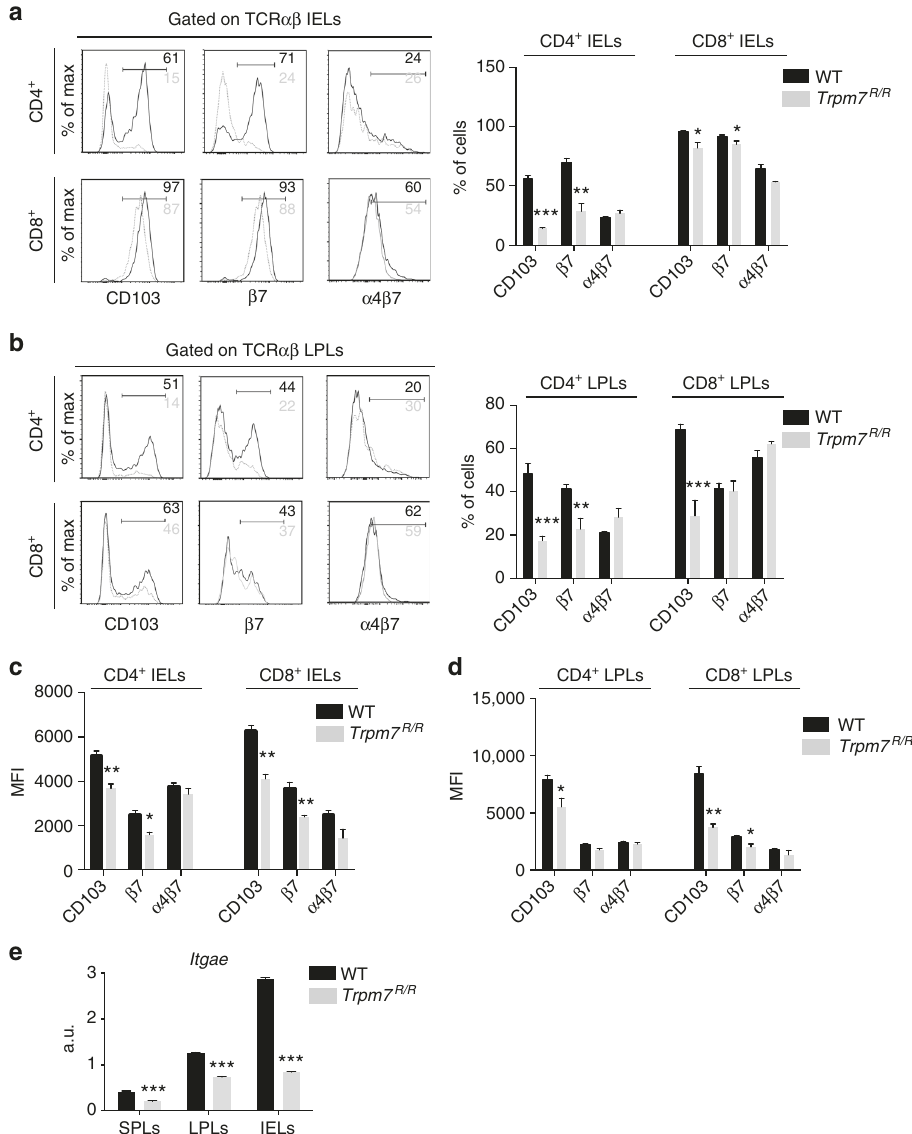
Fig. 3 Trpm7 R/R mutation affects α E β 7 expression in T cells. a Representative histogram overlay of cell surface CD103, β 7 and α 4 β 7 expression of intra- epithelial lymphocytes (IEL, left) and relative statistical analysis (right). Percentages are shown in each gate, bar charts show mean percentages ± s.e.m. ( n = 4). b Representative histogram overlay of cell surface CD103, β α β 7 and 4 7 expression of lamina propria lymphocytes (LPL, left) and relative statistical analysis (right). Percentages are shown in each gate, bar charts show mean percentages ± s.e.m. ( n = 4). c Surface CD103, β 7 , and α 4 β 7 expression in IELs, bar charts show mean fl uorescence intensity ± s.e.m. ( n = 5). d Surface CD103, β 7 and α 4 β 7 expression of LPLs, bar charts show mean fl uorescence intensity ± s.e.m. ( n = 5). e Quantitative real-time PCR of Itgae expression in puri fi ed TCR αβ + CD4 + lymphocytes from spleen (SPL), lamina propria (LPL) or intra-epithelium (IEL). Data are representative results of at least 3 independent experiments. A two-tailed Student ’ s t test was used with * p < 0.05; ** p < 0.01 and *** p < genotypes (Fig. 5a, left and middle). Interestingly, in vitro polarization of naive CD4 + T cells into T H 17 cells, using TGF- β , IL-6 and α IFN- γ , was reduced in Trpm7 R/R compared to WT cells (Fig. 5a, right), consistent with the robust reduction of IL-17 concentration in serum from Trpm7 R/R mice (Fig. 1g) as well as the diminished number of IL17-producing Trpm7 R/R IELs (Fig. 2h). In contrast, T-bet and Ifn- γ mRNA levels were not different among in vitro-differentiated Trpm7 R/R and WT T H 1 cells (Fig. 5b). Since Rorc and IL-17 mRNA levels were reduced in in vitro-differentiated Trpm7 R/R T H 17 cells (Fig. 5b), we analysed STAT3 signalling as a signalling pathway involved in T H 17 differentiation. However, western blot analysis of CD4 +